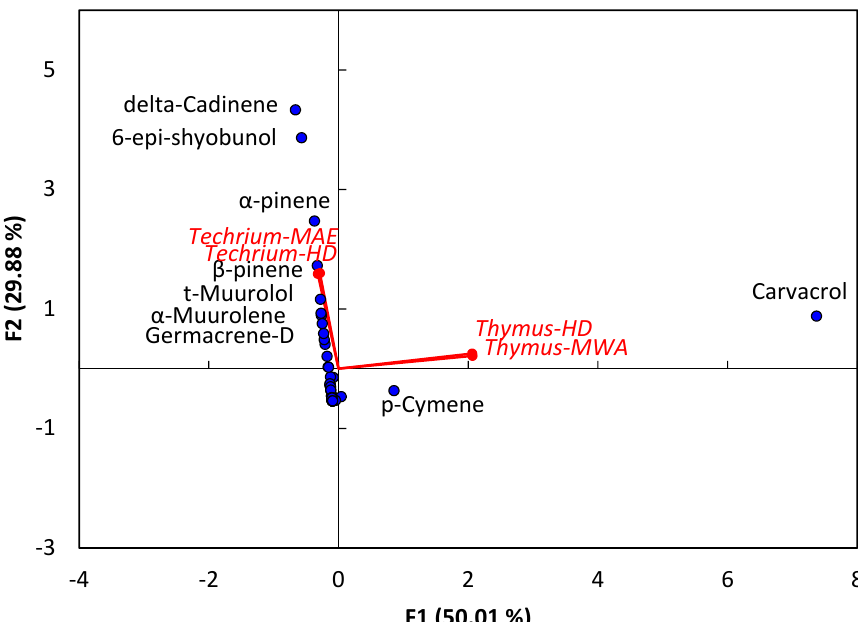
Figure 1. Principal component analysis (PCA) of EO compounds extracted from Teucrium polium and Thymus decussatus using microwave-assisted extraction (MAE) and hydrodistillation (HD) methods. Table 2. Phytotoxic inhibitory activity of EOs extracted from Teucrium polium and Thymus decussatus using microwave-assisted extraction (MAE) and hydrodistillation (HD)